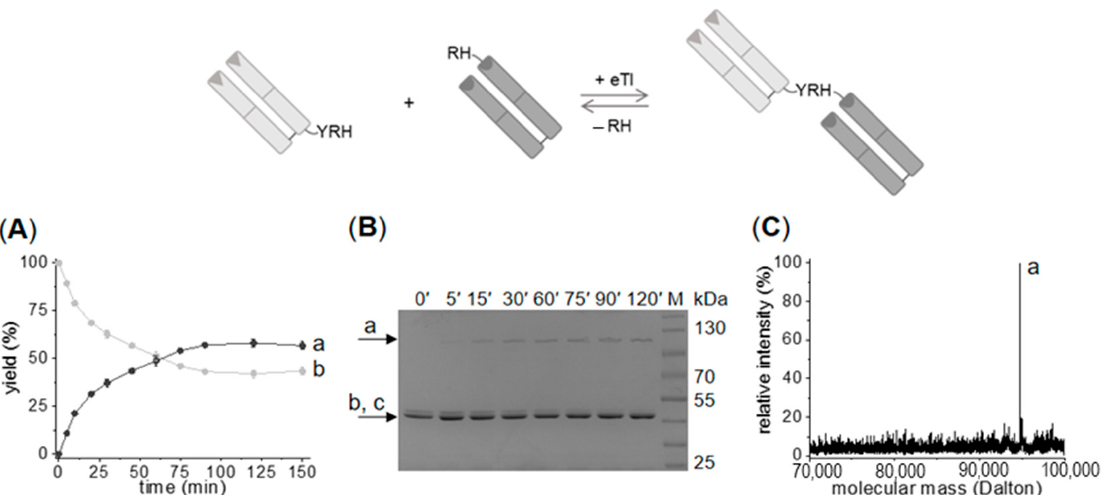
Figure 2. Synthesis of C - to N -terminal conjugated bsFab via direct eTl-coupling of anti-ErbB3-Fab- YRH and anti-ErbB2-RH-Fab. ( A ) Kinetics of product formation with reaction yields of about 60%, a: anti-ErbB3-YRH-anti-ErbB2-bsFab, b: anti-ErbB2-RH-Fab; ( B ) Time-resolved SDS-PAGE analysis of coupling reaction, c: anti-ErbB3-Fab-YRH, M: molecular marker; ( C ) MS analysis of the final bsFab product after purification by SEC, anti-ErbB3-YRH-anti-ErbB2-bsFab M calcd : 94,804 Da, M found : 94,805 Da. Light grey Fab: anti-ErbB3-Fab-YRH, dark grey Fab: anti-ErbB2-Fab-RH; eTl: enhanced Trypsiligase. Reaction conditions: 20 µM anti-ErbB2-RH-Fab, 100 µM anti-ErbB3-Fab-YRH, 2.5 µM eTl, 50 µM ZnCl 2 , 100 mM HEPES/NaOH, pH 7.8, 100 mM NaCl, 10 mM CaCl 2 .